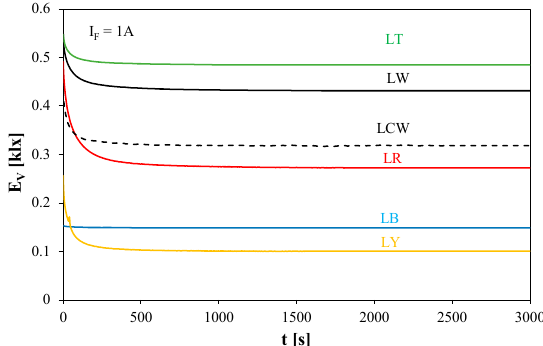
Figure 14. Waveforms of illuminance measured when exciting the tested diodes by a step of current. Measurements, the results of which are shown in Figures 7–14, were performed while feeding one tested diode only. Other diodes were not fed. In contrast, Figures 15–17 illustrate the influence of mutual thermal couplings on the thermal and optical properties of the tested diodes. power LEDs measured using the set-up shown in Figure 5. Measurements were performed while heating the LT diode (Figure 15a) and the LY diode (Figure 15b). The LT diode was situated in the middle of the PCB including all the diodes, whereas the LY diode was close to the border of this PCB.